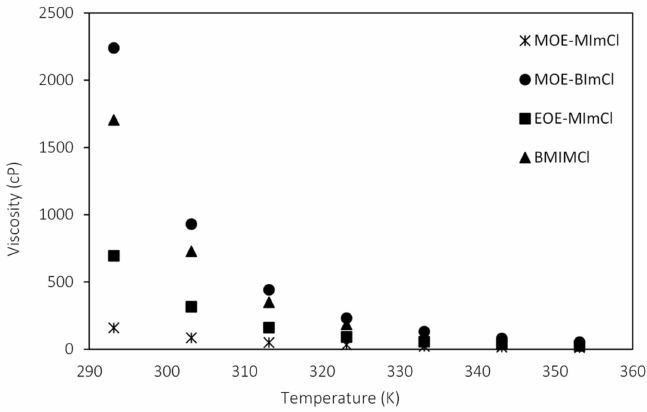
Figure 4. Viscosity for ILs.